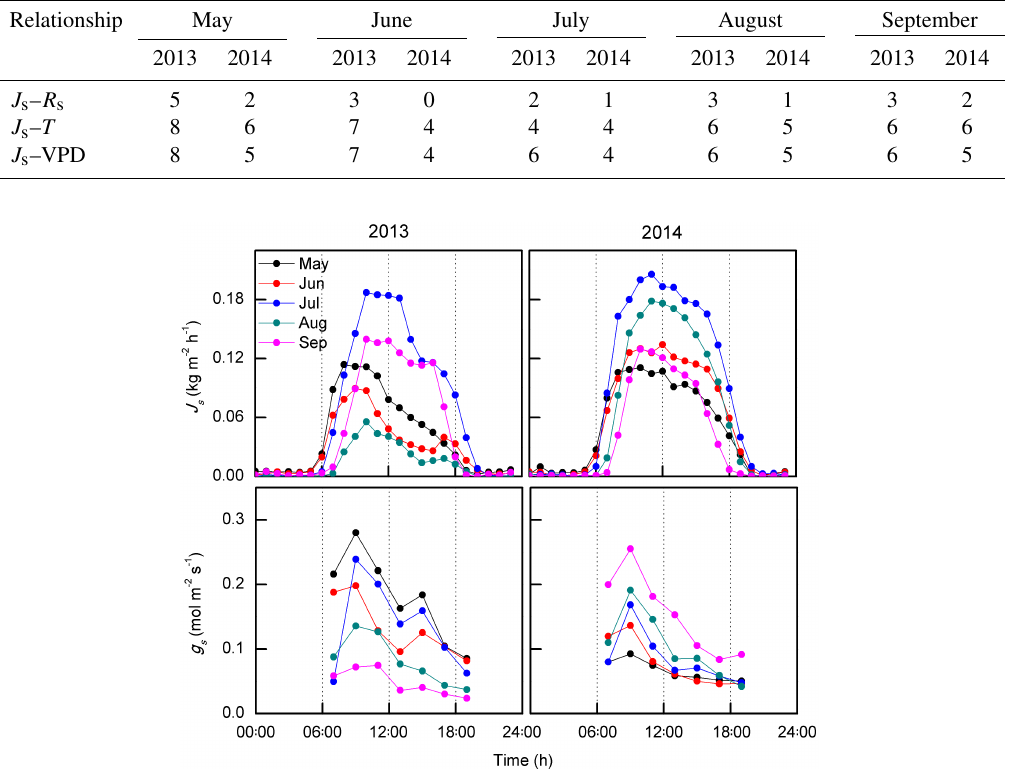
Figure 6. Mean monthly diurnal changes in sap flow per leaf area ( J s ) and stomatal conductance ( g s ) in Artemisia ordosica during the growing season (May–September) for both 2013 and 2014. Each point is given as the mean at specific times during each month.